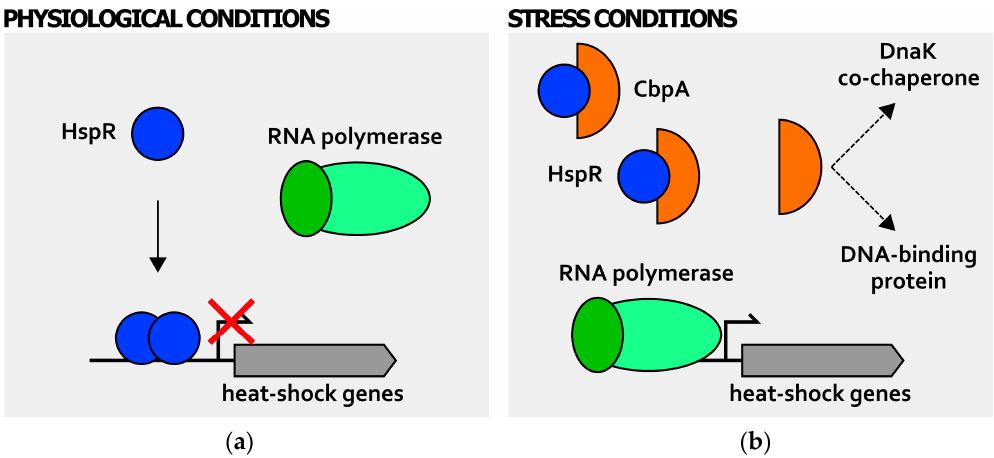
Figure 4. Posttranscriptional regulation of heat-shock genes expression: CbpA-dependent modulation of HspR activity. During normal growth ( a ), HspR (blue circle) binds (solid arrow) and represses heat-shock genes’ transcription by a mechanism of steric hindrance; upon stress insults ( b ), CbpA protein (orange half-circle) accumulates in the cytoplasm and interacts with HspR. This direct interaction hinders HspR DNA-binding capabilities to target promoters, whose transcription can take place. The RNA polymerase containing the vegetative σ factor is represented by green ovals (dark green oval depicts vegetative σ factor, while light green oval represents the core RNA polymerase). Bent arrow indicates the transcription start site. In analogy with E. coli CbpA, preliminary results suggest that CbpA of H. pylori possesses both co-chaperone and DNA-binding